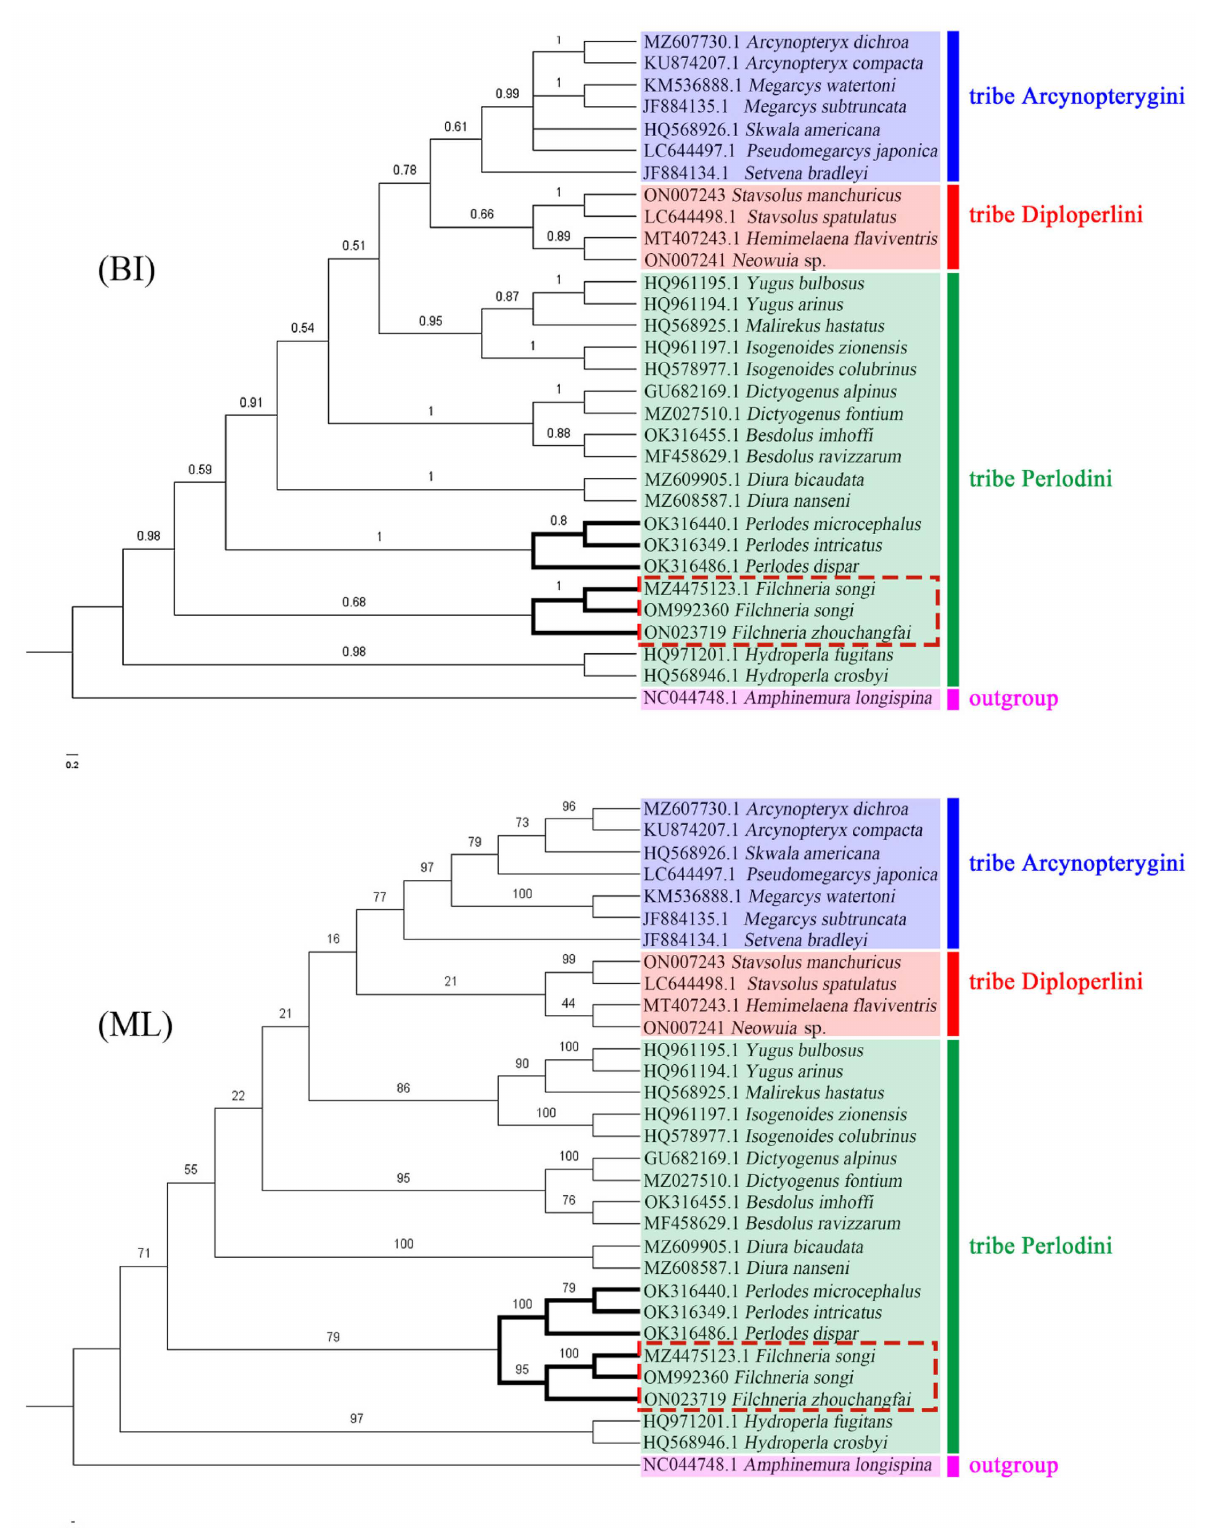
Figure 14. Phylogenetic relationships of Perlodinae, based on Maximum‑Likelihood (ML) and Bayesian Inference (BI) methods. Numbers at the nodes represent posterior probabilities. Species names are marked to the right of each